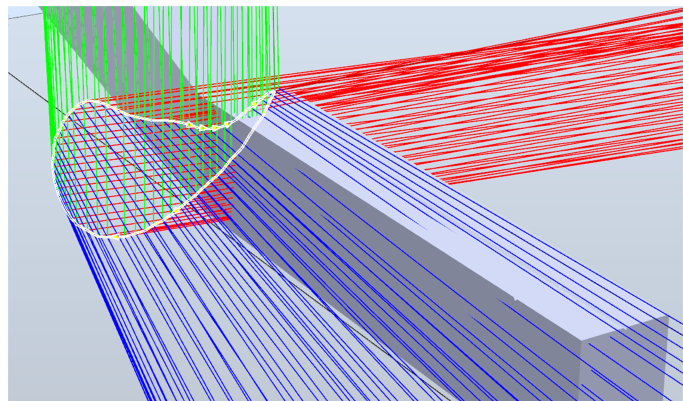
Figure 6. Programmed masticatory trajectory path in the RobotStudio